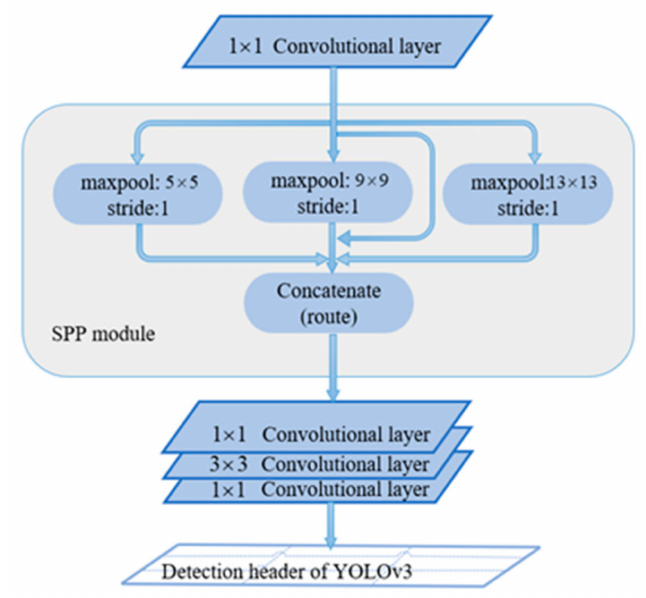
Figure 3. Architecture of the SPP module used in YOLOv3-SPP3.